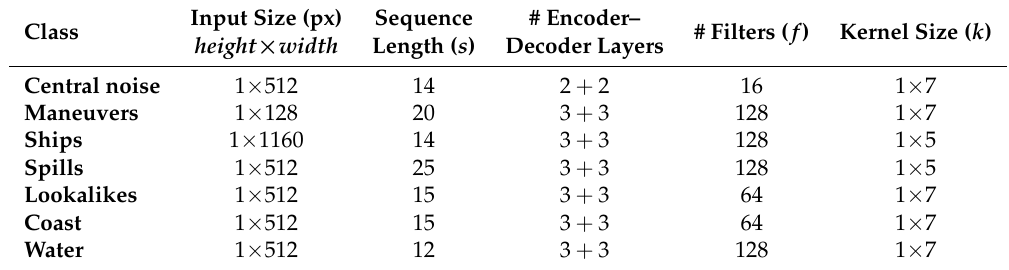
Table 2. Topology of each of the CMSAE networks used in the proposed algorithm.